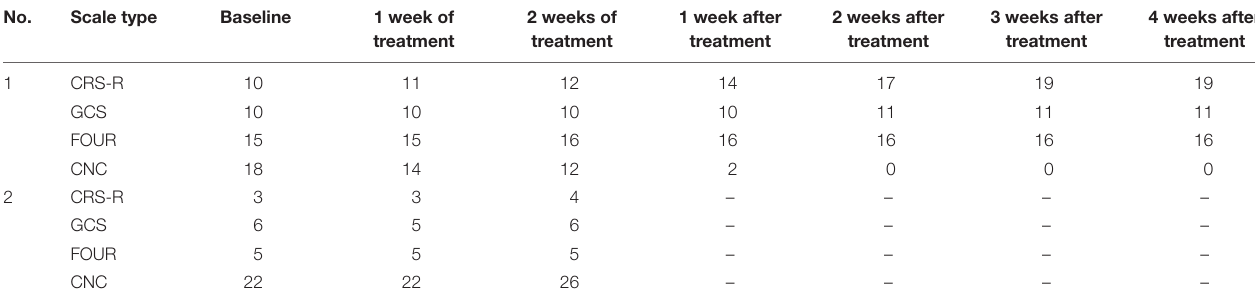
TABLE 2 | Clinical scores of the two patients throughout the study. No.